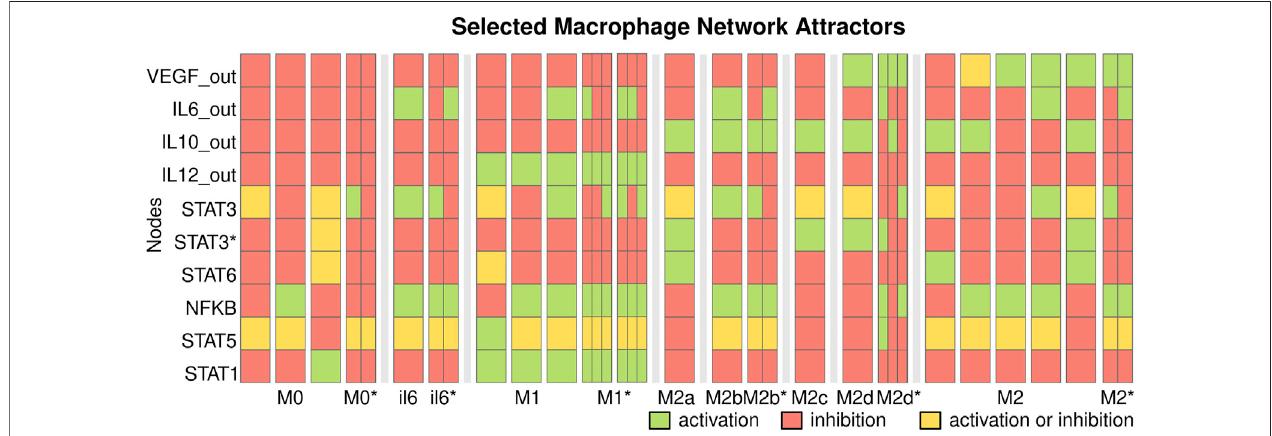
FIGURE3| Selectedmacrophageregulatoryattractors.Theattractorsofthemacrophageregulatorynetworkcorrespondtocelltypes.Eachcolumncorresponds to key nodes of a state; attractors are separated by white spaces and cell types by black bars. We include the cyclic attractors as narrow columns that represent the oscillation. Each node can be active (green) or inactive (red), or active or inactive (yellow). The network recovers the attractors corresponding to M1, M2a, M2b, M2c, M2d, and M2-like cell